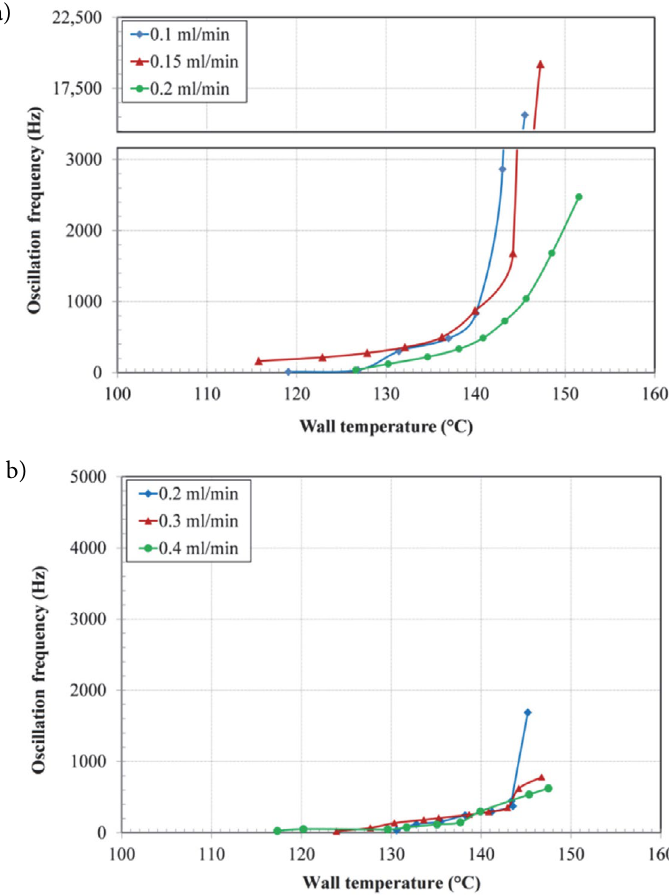
Figure 10. Oscillation frequency dependence on wall temperature at various volumetric flows in a single (a) 50 × 50 µm and (b) 100 × 50 µm micro-